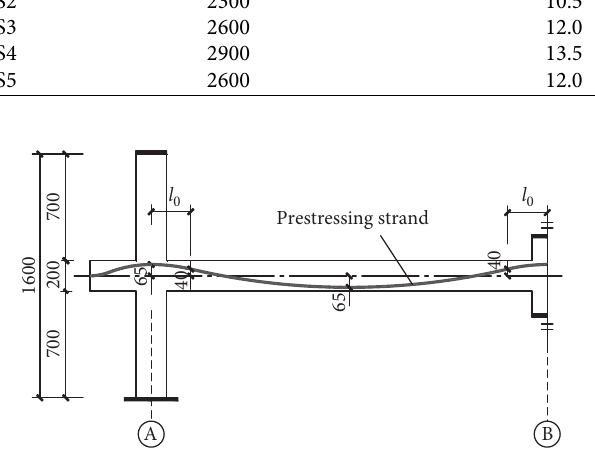
Figure 3: Layout of the prestressing